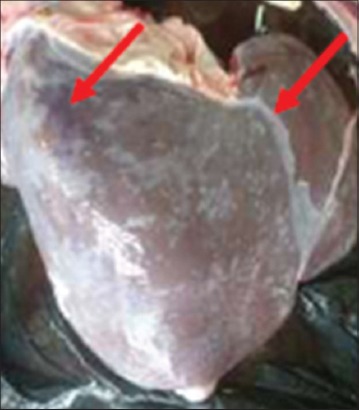
Fibrinous and hemorrhagic liver.